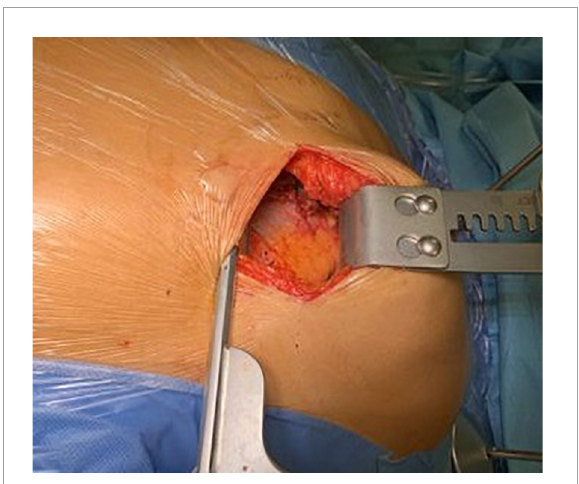
FIGURE1 Left thoracotomy for LIMA harvesting using a lifting retractor.